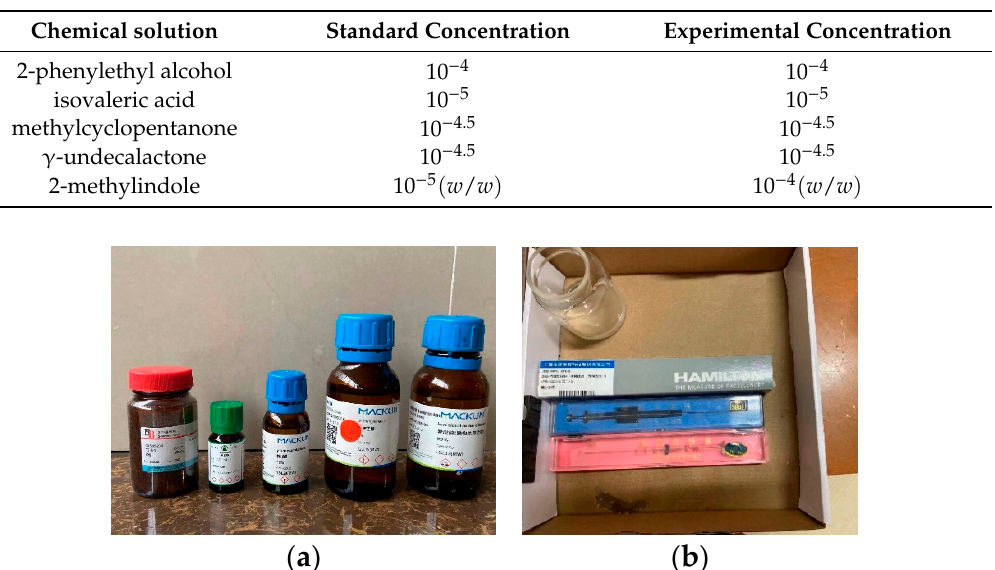
Table 1. Concentration of five kinds of standard solutions.